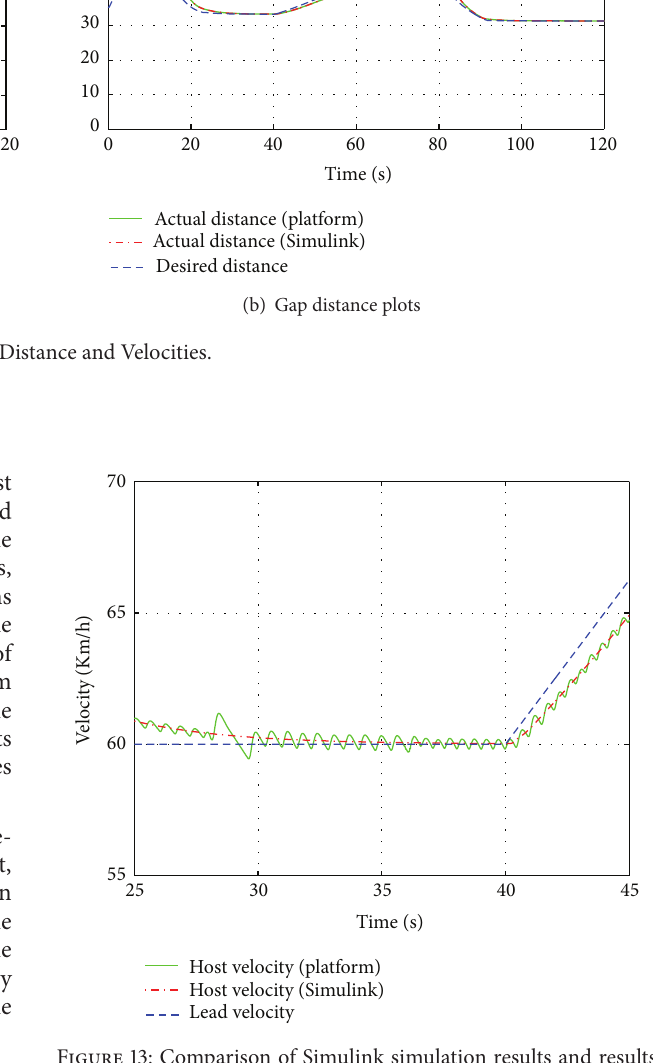
Figure 13: Comparison of Simulink simulation results and results from the experimental